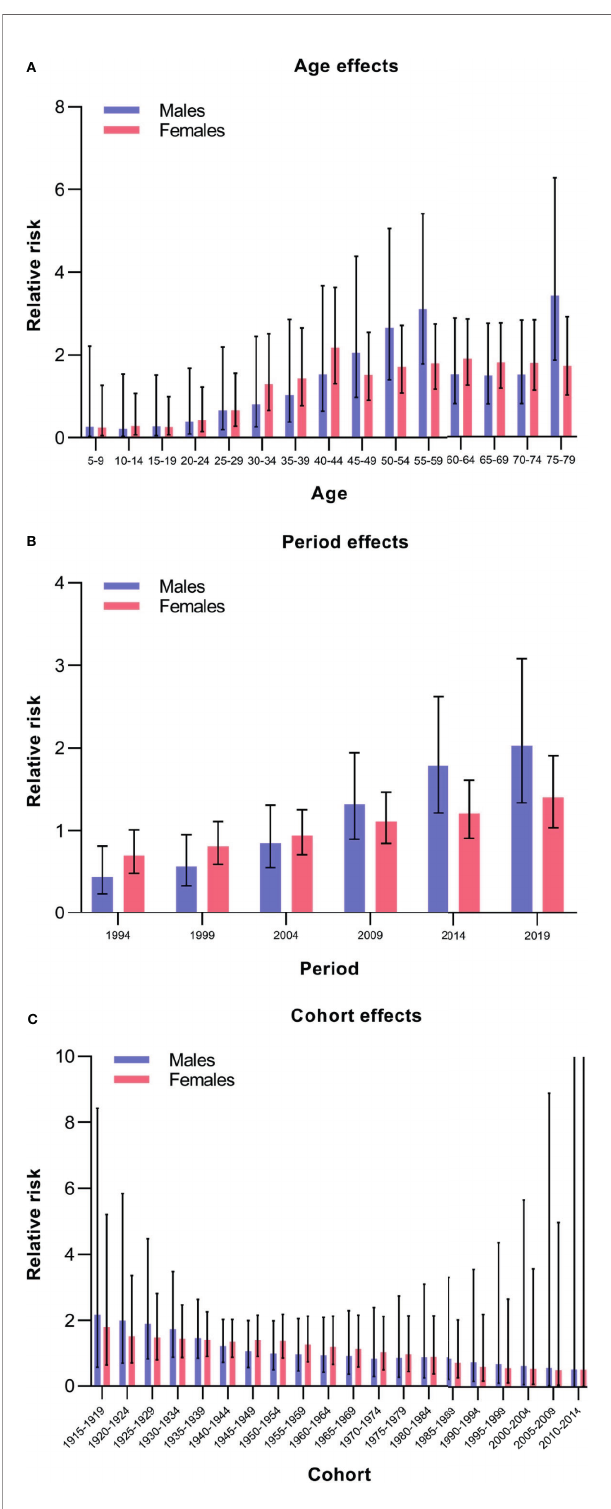
FIGURE 4 | Relative risks of thyroid cancer incidence in China from 1990 to 2019 due to age (A) , period (B) , and cohort (C)